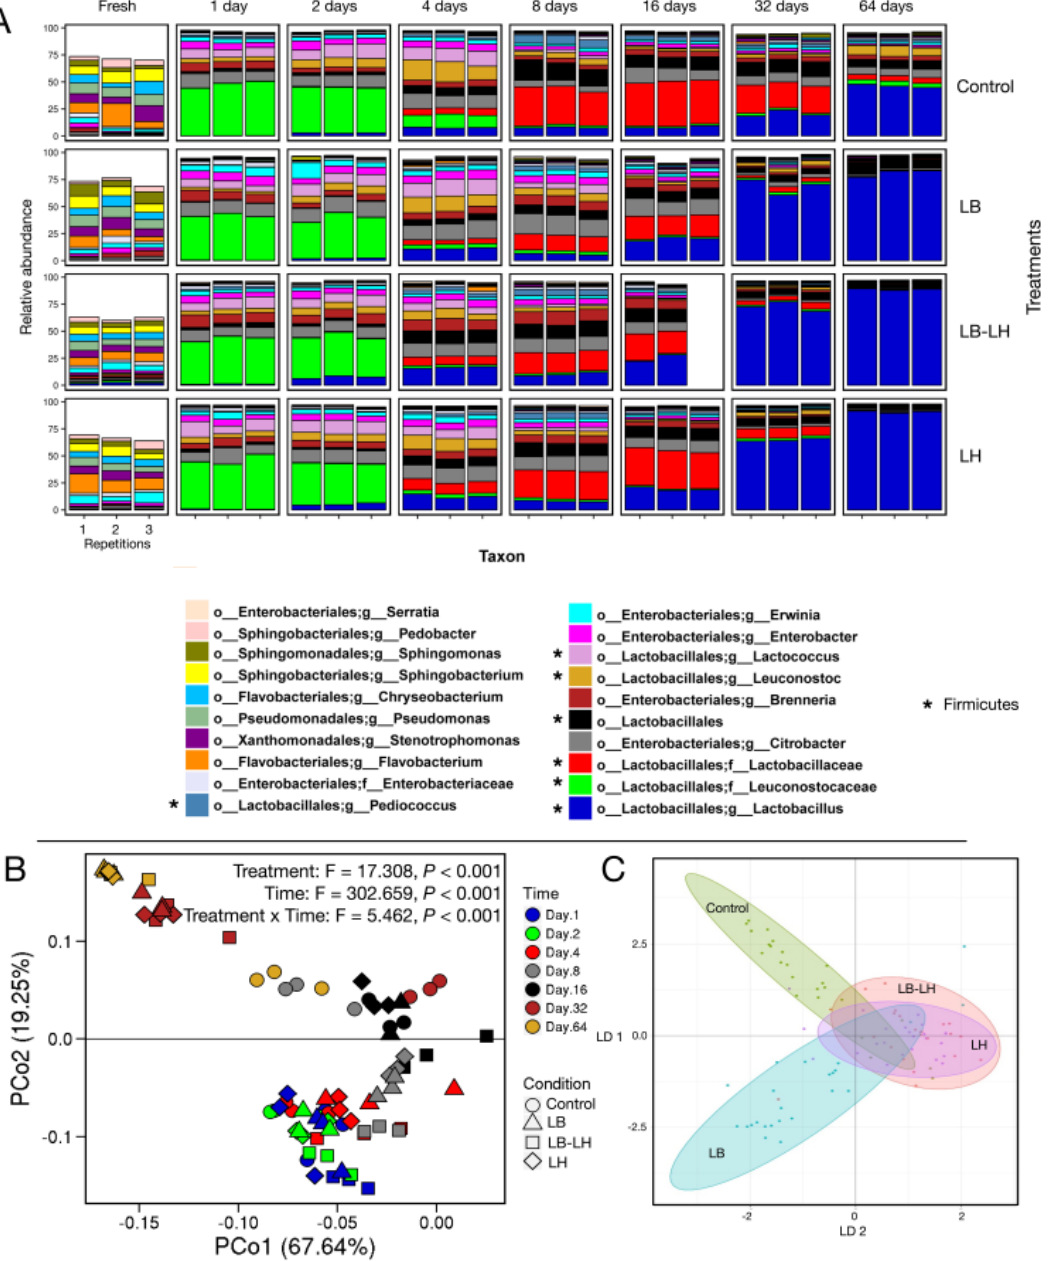
Figure 1. Bacterial composition by 16S rDNA gene amplicon metasequencing (V4 region) in corn silages under four inoculation treatments for eight fermentation periods, between fresh and 64 days of ensiling ( A ). Each panel corresponds to one fermentation treatment (inoculant × time) and the diversity results of three independent repetitions. The color code shows the 20 most abundant taxa computed using all 32 ensiling conditions. Taxon identification was at the genus level. Results of the principal coordinates analysis ( B ) and the linear discriminant analysis ( C ) computed from the complete metasequencing results are shown. Principal component analysis of the weighted Unifrac distance values was performed without the results for the fresh samples because the dissimilarity was so great that the e ff ect of fermentation time was hard to visualize. Operational taxonomic units (OTUs) identified by * belong to the Firmicutes